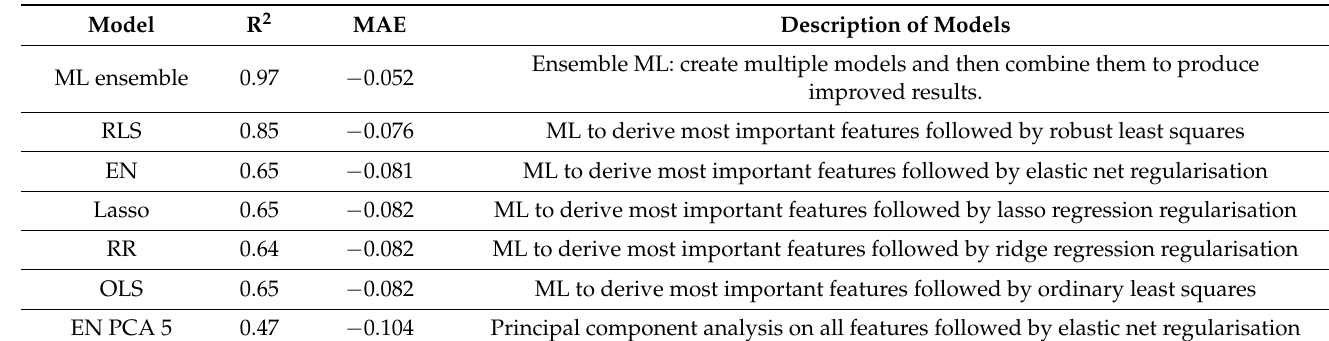
Table 2. Results of the kaolinite models.